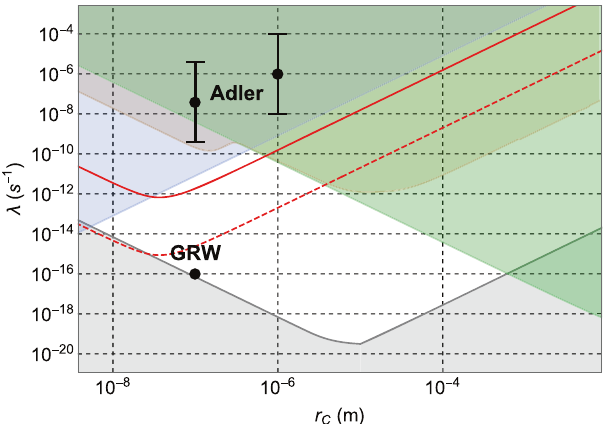
Fig. 3 Exclusion plots for the Continuous Spontaneous Localization (CSL) model parameters { r c , λ } from non-interferometric experiments. The solid, red line represents the bound on the CSL parameters that can be potentially achieved through non-interferometric experiments in space with the parameters in Table 1. Here, the main limitation is due to the environmental conditions of pressure and temperature. The dashed red line indicates the upper bound that could be obtained by decreasing the pressure to P = 3 × 10 − 14 Pa so that the main limitation would be represented by the statistical error. These bounds are compared to the strongest bonds and corresponding excluded parameter regions present in literature: X-rays emission (blue region) 70 , LISA Path fi nder (green region) 53,55 , multilayer cantilever (brown region) 41 . The gray region is the theoretical lower bound, which is estimated by requiring the collapse to become effective at the mesoscopic scale where the quantum-to-classical transition is expected 127 . The black dots, with their error bars, represent the GRW ’ s 43 and Adler ’ s 44,128 theoretical values for the CSL